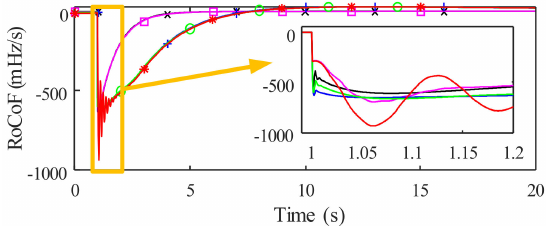
Figure 16. Comparison between the SG speed RoCoF tp on load change for VSM (red, * marked), VI (green, circle marked), and droop (blue, + marked) control systems if the BESS assumed 100% of the load variation versus 50% with droop (black, × marked) and VSM (magenta, square marked) control systems.